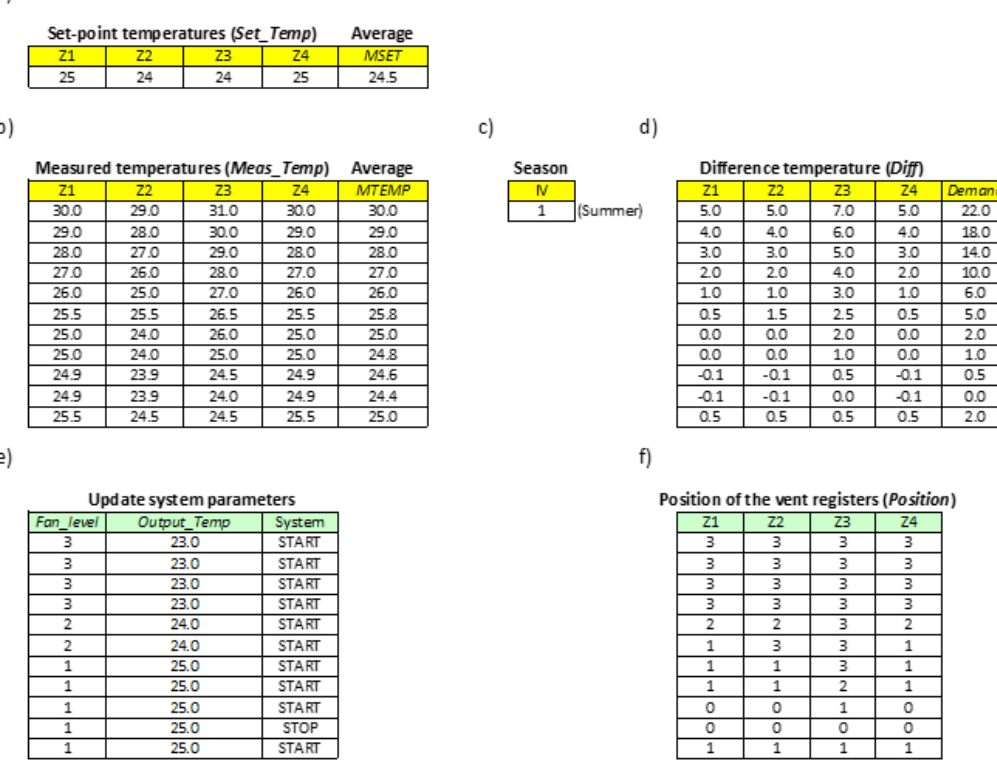
Figure 12. Example of simulation of the algorithm in the summer season. ( a ) Set-point temperatures, ( b ) measured temperatures, ( c ) season, ( d ) di ff erence temperatures, ( e ) updating system parameters, ( f ) position of the vent